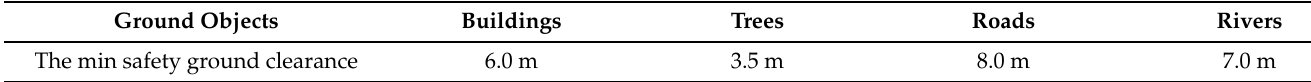
Table 3. Min safety ground clearances between different ground objects of 220 kV transmission